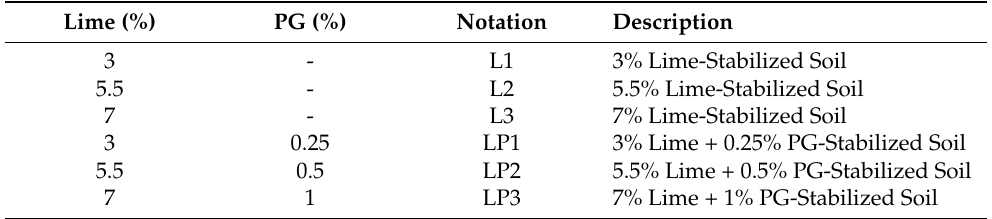
Table 3. Lime and Optimum PG Combinations Used for